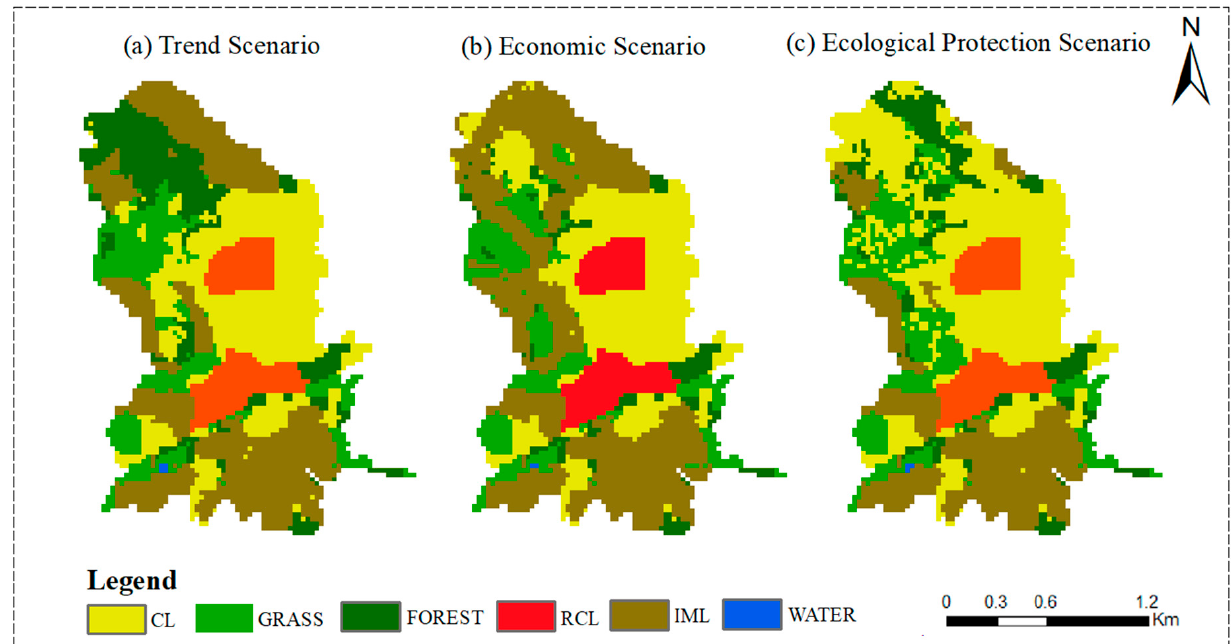
Figure 10. Land use forecast results of three scenarios in 2026.